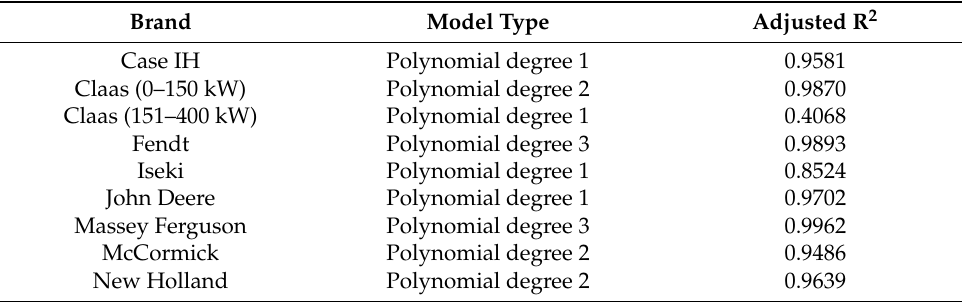
Table 6. Summary of best results with new tractors data by brands.